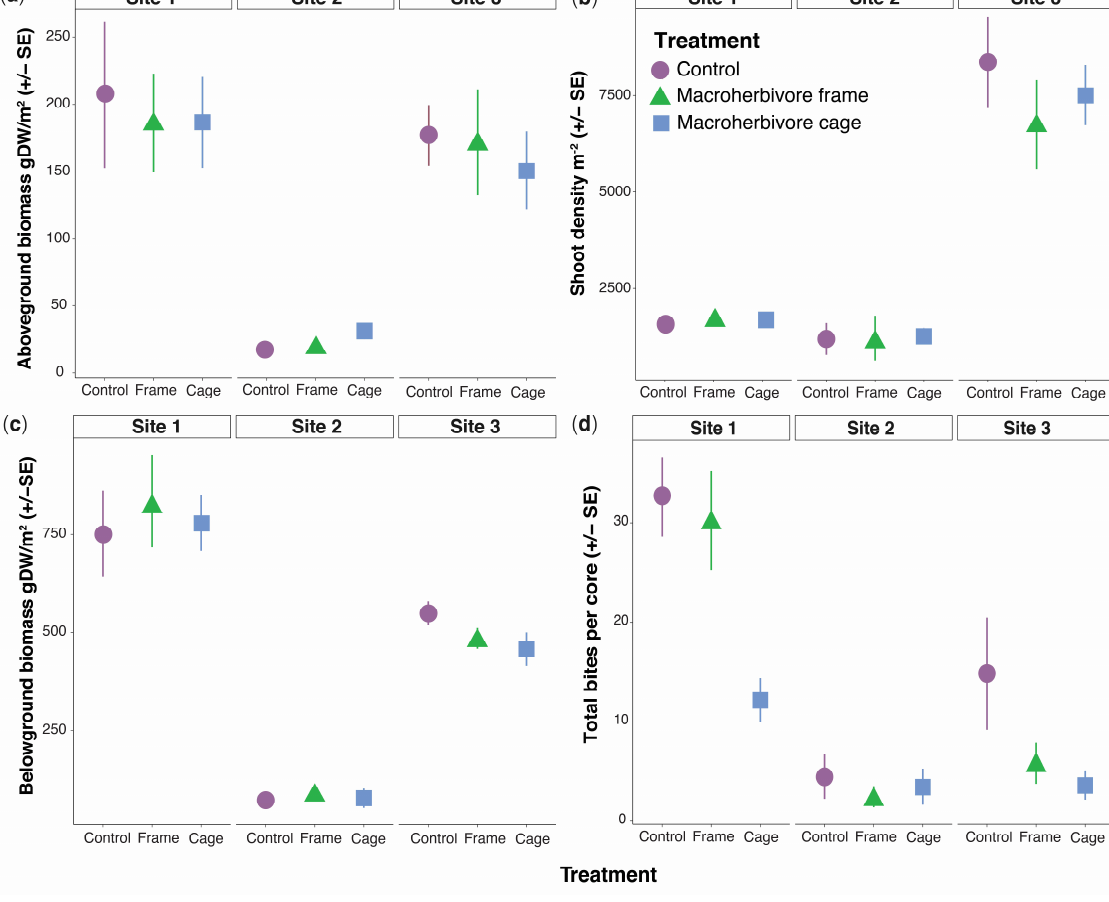
Figure 5. Aboveground biomass ( a ), shoot density ( b ), belowground biomass ( c ) and bite marks per core ( d ) in all treatments at all sites at the end of the exclusion cage experiment.